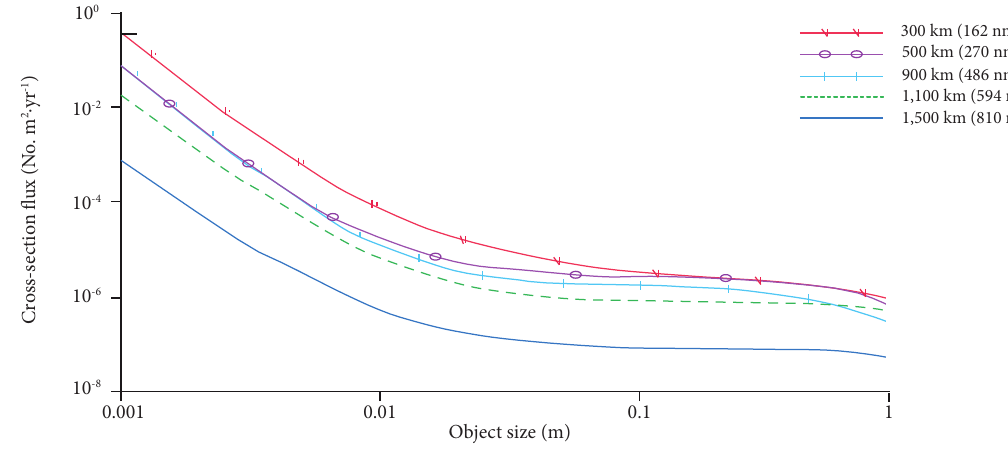
Figure 3. Orbital debris flux in the year 2005 for satellites at various